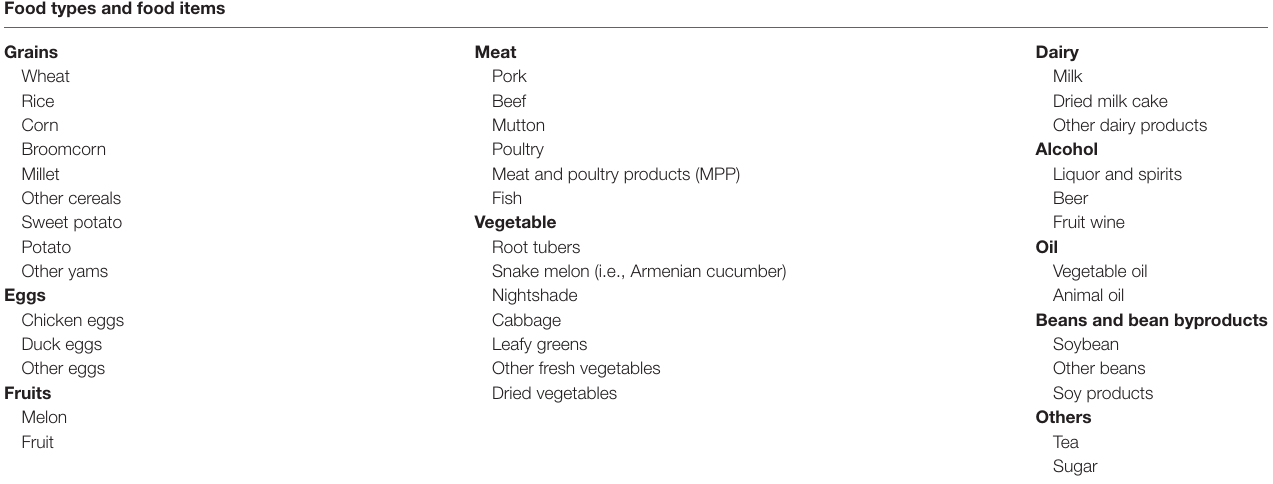
TABLE 3 | The main food types and items consumed by rural residents at the study sites. Food types and food items